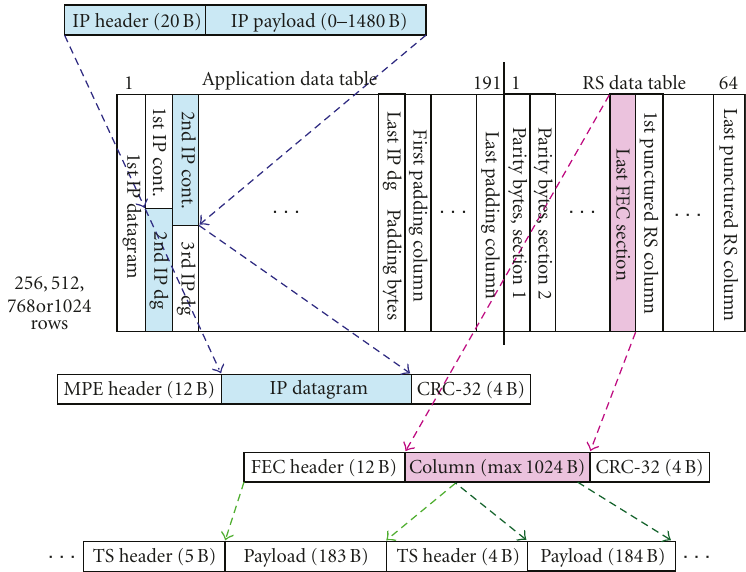
Figure 1: The DVB-H link layer